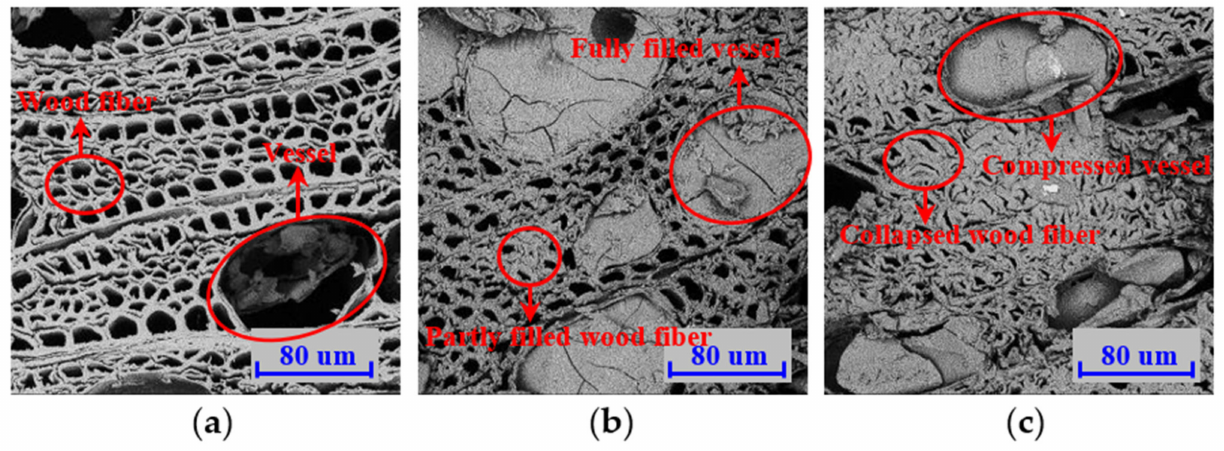
Figure 15. Transverse SEM images of control ( a ) and BPF specimens with 0 ( b ) and 20% ( c ) compres- sion ratios prior to cone tests.